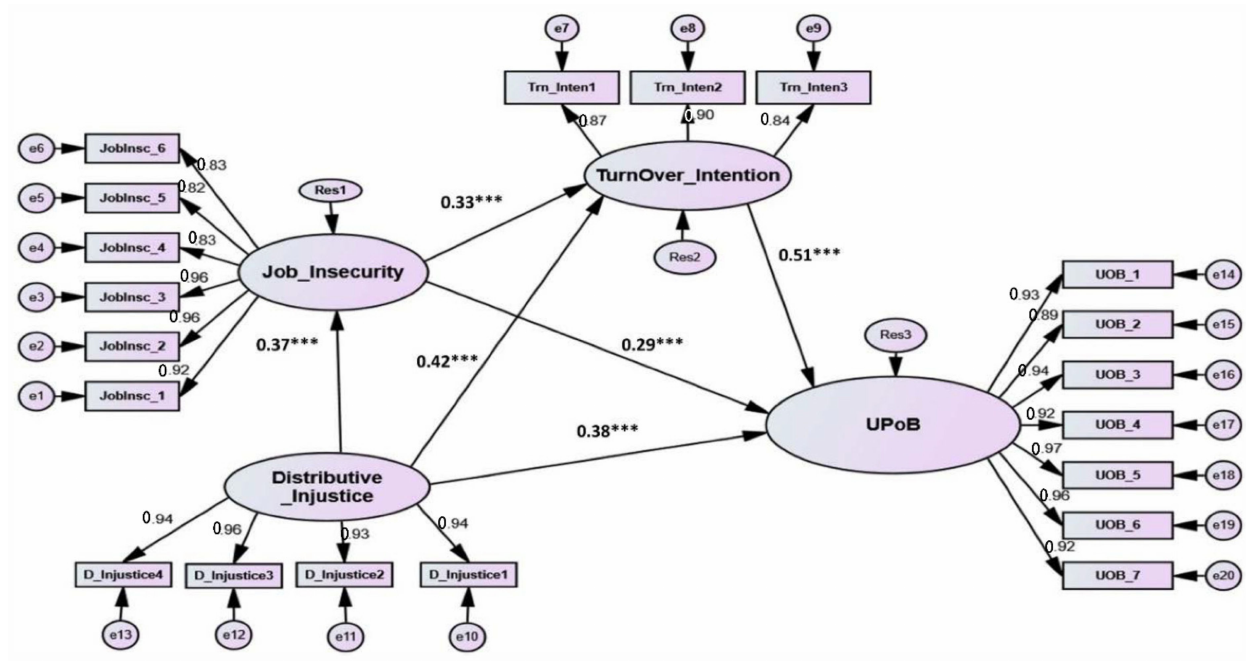
Figure 2. The structural Model. Note: *** p <